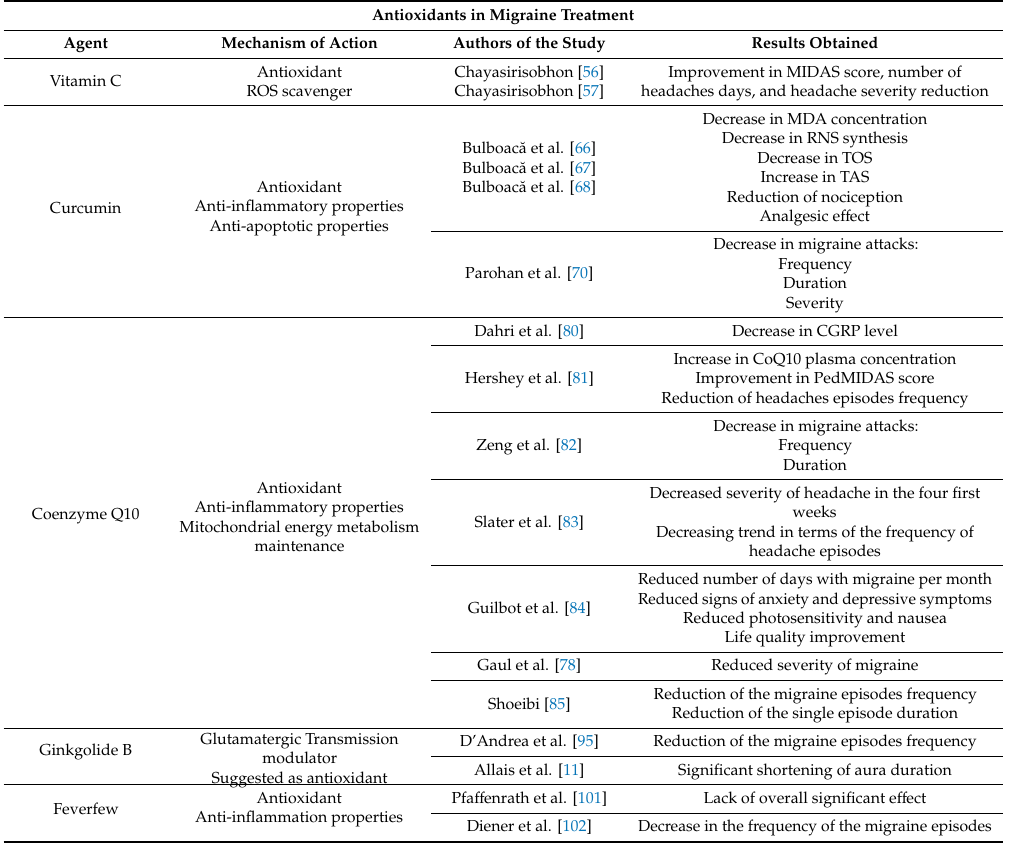
Table 2. Antioxidants in migraine